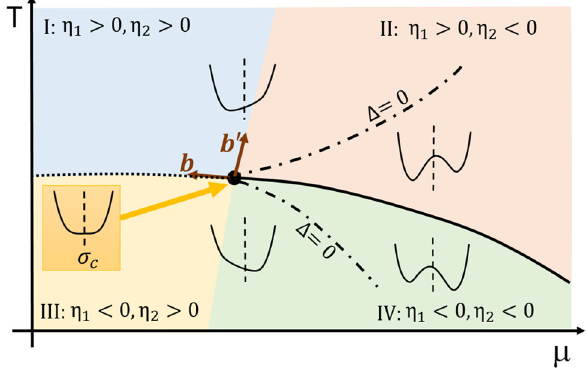
Fig. 1 A sketch of the QCD phase diagram. The colored 4 zones (I– IV) are sorted according to the sign of η 1 and η 2 . The dash-dotted lines ) 2 + ( η 2 ) 3 = 0, are the boundary of the determined by Δ ≡ ( η 1 2 η 4 3 η 4